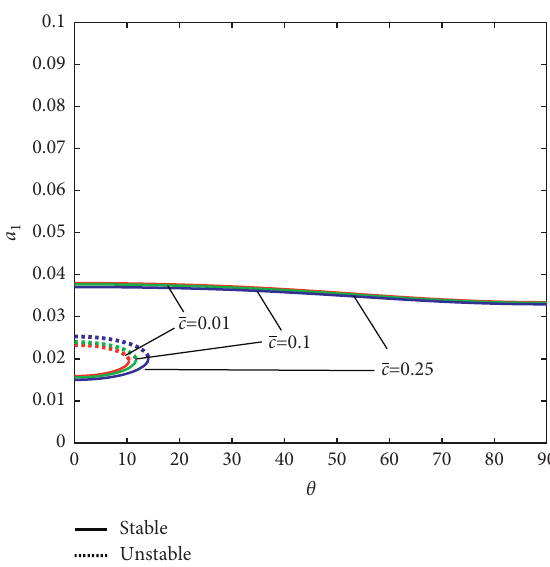
Figure 16: Amplitude versus ply angle with different detuning parameter values (L/d � 10, c � 0.01, case I).